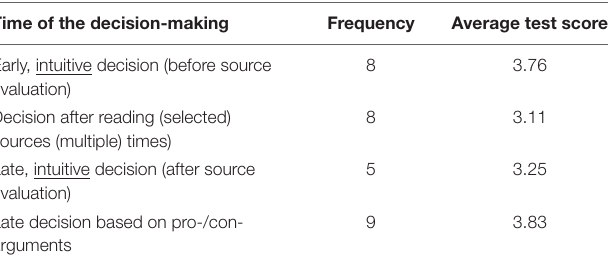
TABLE 2 | Time of decision-making and type of